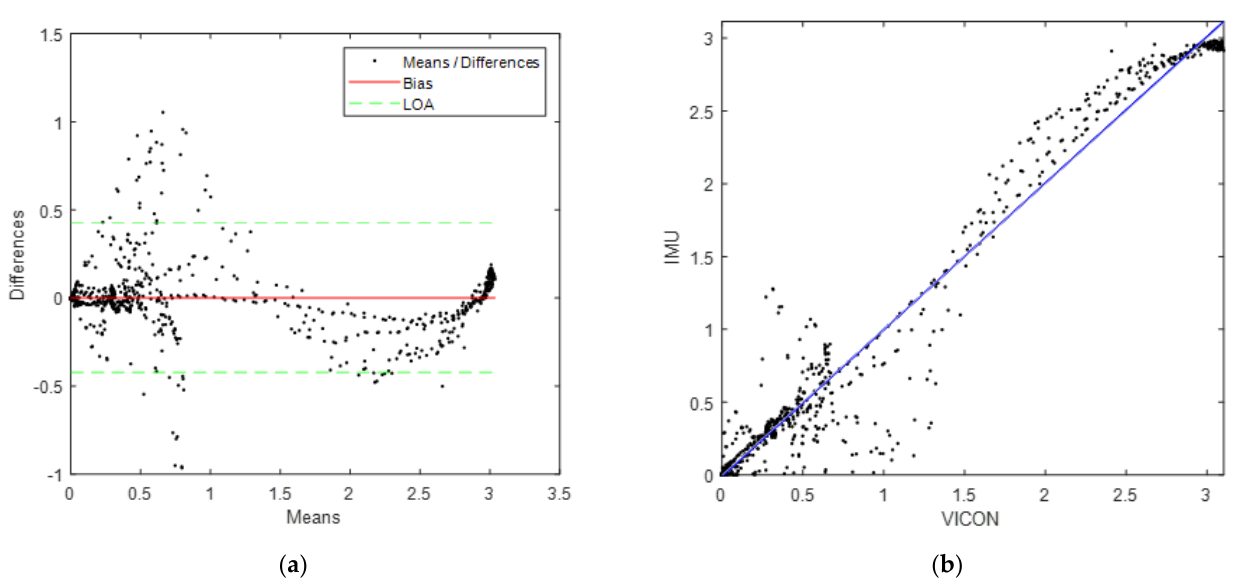
Figure 3. Linear acceleration Bland-Altman plot between the IMU and VICON system. ( a ) The systematic bias (solid line) and the 95% limits of agreement (dashed line) are shown. ( b ) Linear regression (solid line) created by the individual comparison (star markers).